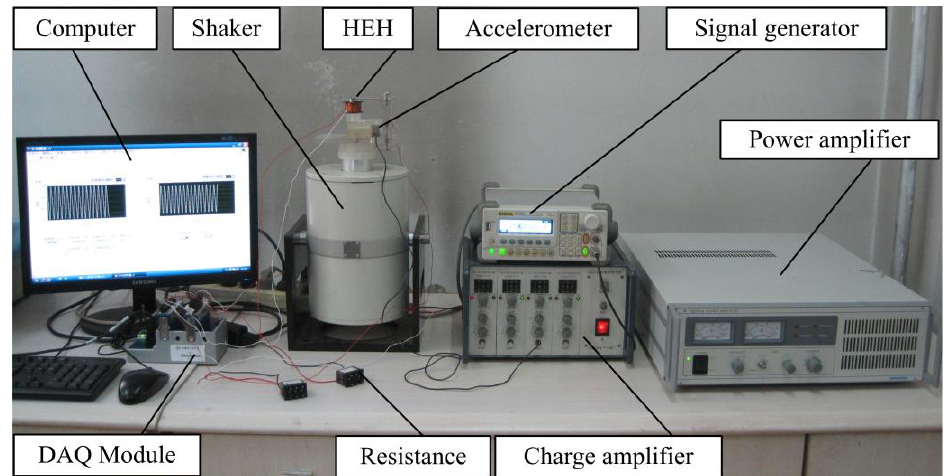
Figure 10. Experimental setup for the HEH.